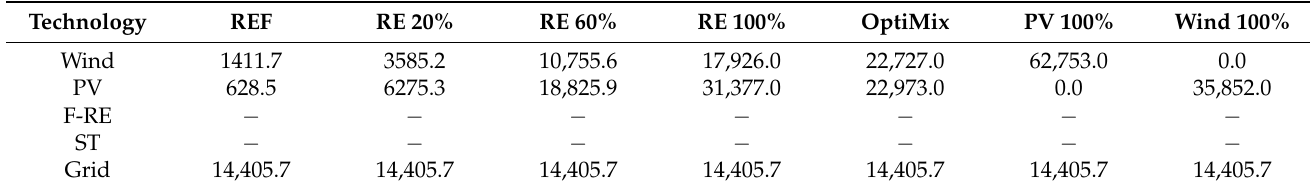
Table A9. Installed capacity in kW of renewable resources in renewable integration scenarios.